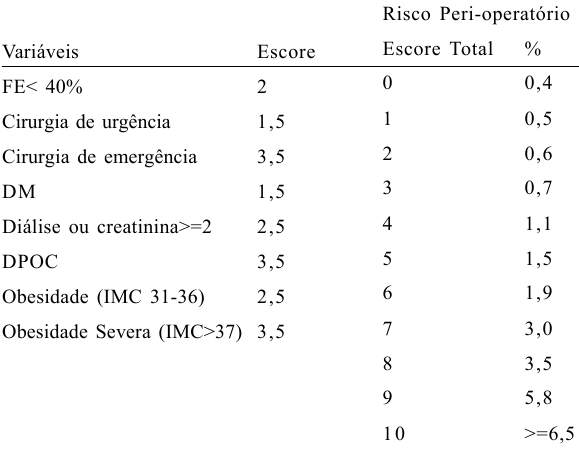
Tabela 3. Estimativa de Risco Pré-operatório para Mediastinite.